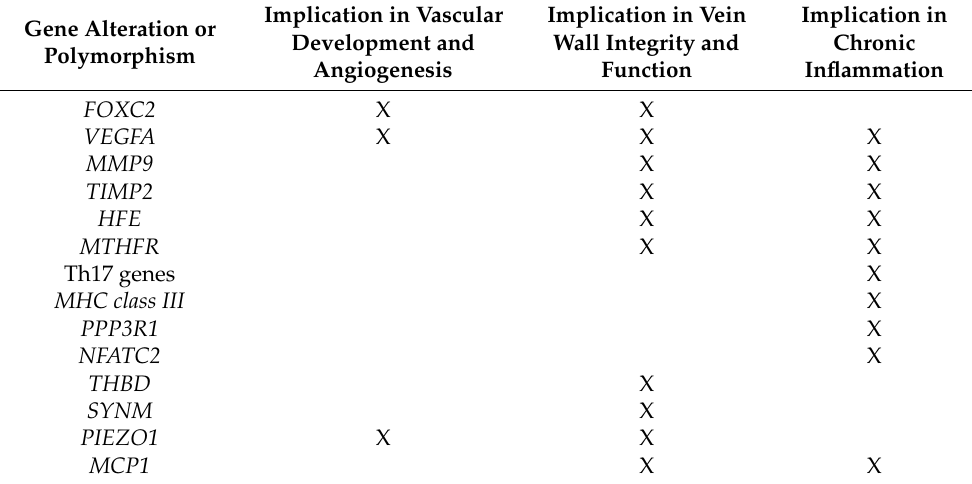
Table 1. Main genes and related implications in CVD